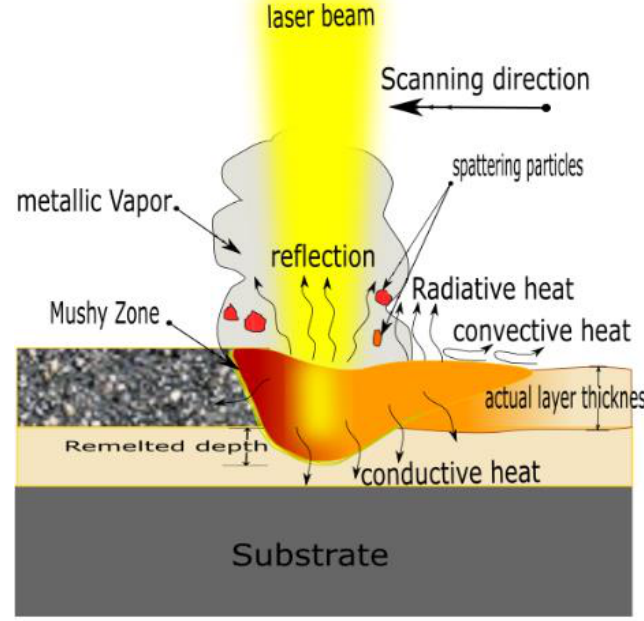
Figure 3. Schematic diagram of heat transfer mechanisms away from the melting pool in L-PBF.